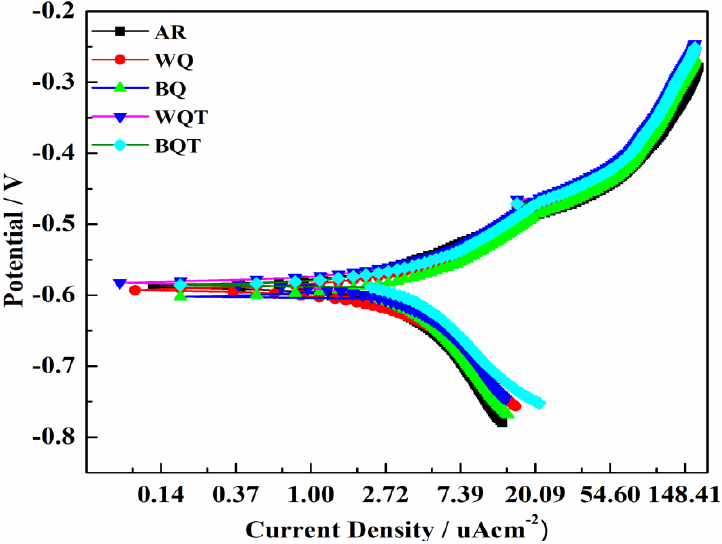
Figure 5. Tafel scans of as-received and quench-hardened, tempered steel analyzed in 1 vol% HNO 3 solution.